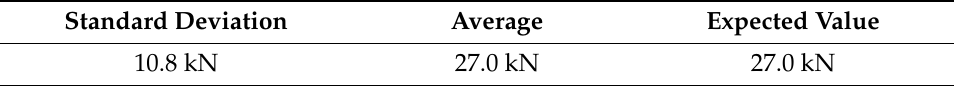
Table 4. Brake-activation threshold